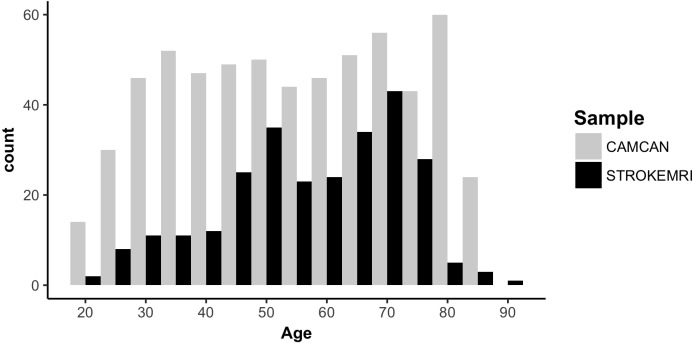
Histogram of the age distribution for each sample.